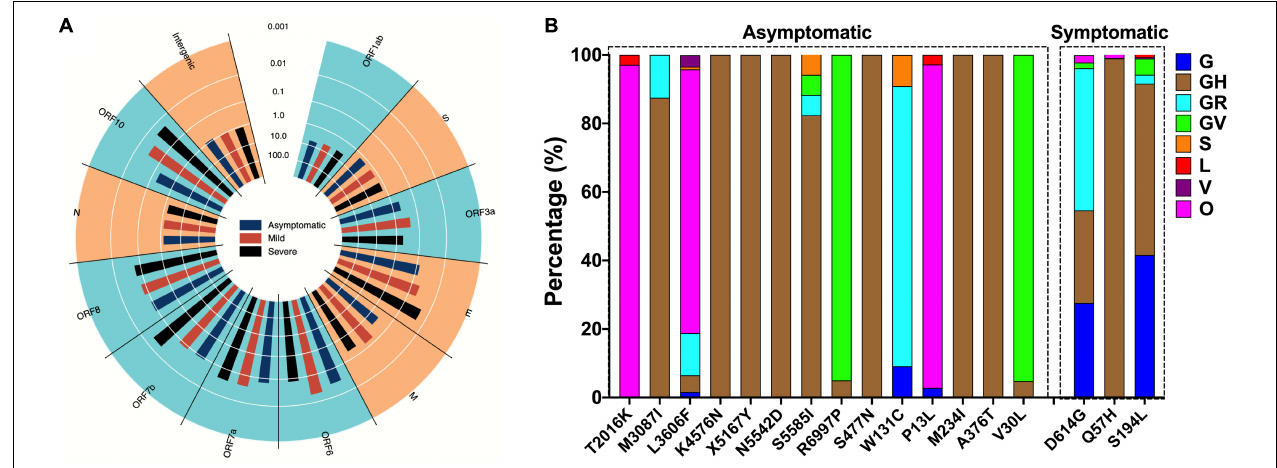
FIGURE 2 | Identification of mutation hotspots in different clinical outcomes. (A) Missense mutations of the three clinical outcomes distributed in different genes. (B) Major SNV frequency in asymptomatic, mild/moderate, and severe outcomes.